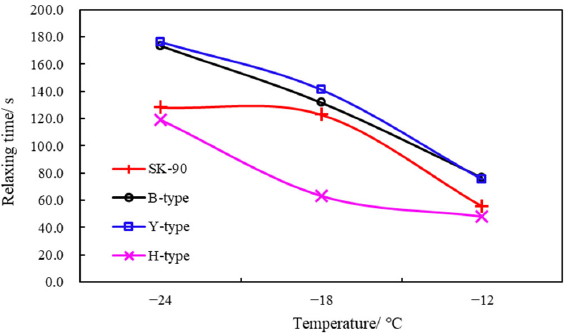
Figure 5. The relaxation time of asphalt binders under different temperatures. The dissipation energy ratio shows the asphalt binder’s ability to relax; the higher the dissipation energy ratio, the greater the material’s low-temperature crack resistance [37]. Figure 6 presents the dissipation energy ratio for the four binders and the following trend: H-type, B-type, Y-type, and SK-90. The low-temperature performance of the H-type is the best in terms of dissipation energy, which is consistent with the relaxation time evaluation fi ndings. The dissipation energy ratio of asphalt binders reduces as the temperature drops, demonstrating that the dissipation energy in the binders decreases, the stored en- ergy rises, and low-temperature crack resistance worsens. In the temperature range of − 18 °C~ − 12 °C, the dissipation energy ratio of the four binders decreases signi fi cantly, while in the temperature range of − 24 °C~ − 18 °C, the dissipation energy ratio of the four materi- als exhibits a minor reduction, indicating that as the temperature drops, the elastic ratio of the binders rises, but as the temperature drops further, the binder approaches a glassy state. Figure 6. Dissipation energy ratio of the binders under di ff erent temperatures. 3.2.2. Creep Sti ff ness and Creep Speed Figures 7 and 8 display the S and m numbers of the four binders. Low-temperature crack resistance becomes worse as the temperature lowers due to an increase in asphalt’s S value. Under various low-temperature circumstances, the order of S for the four bind- ers from large to small is SK-90, B-type, Y-type, and H-type. From the sti ff ness perspective, the H-type HVM binder has a be tt er low-temperature crack resistance than SK-90, B-type, and Y-type asphalt. While the temperature decreases, the m value of asphalt increases, but there is no apparent consistency in the variation of the m value of the four binders under various temperature conditions. It can be seen that di ff erent asphalts show the same law: under low temperature conditions, the creep sti ff ness modulus of asphalt increases while the creep rate decreases; the creep sti ff ness modulus can be tt er re fl ect the modulus